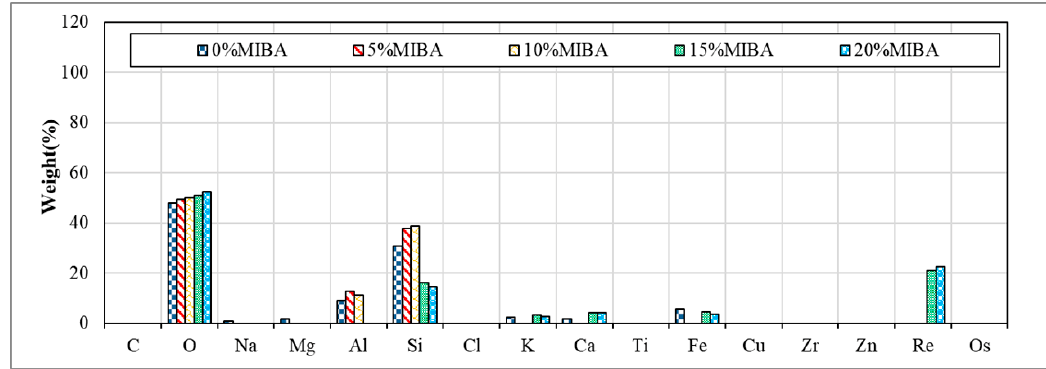
Figure 14. EDS of 10% SSA and various MIBA replacements at 1100 °C kiln temperature.